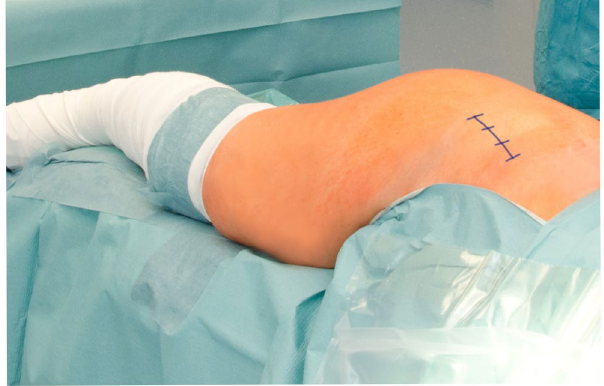
Figure 1. Patient position and skin incision of minimally invasive THA through an anterolateral approach in the lateral decubitus position.